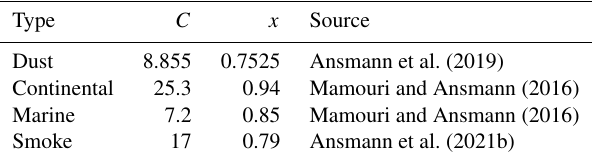
Table 1. POLIPHON conversion factors ( C ) and extinction expo- nents ( x ) for different aerosol